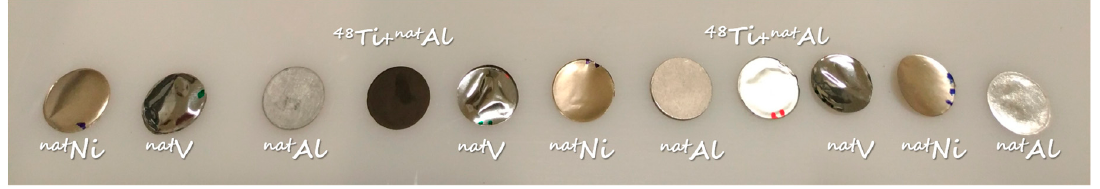
Figure 7. Schematic description with photographs of the key steps of the radiochemical separation process developed for the COME project.